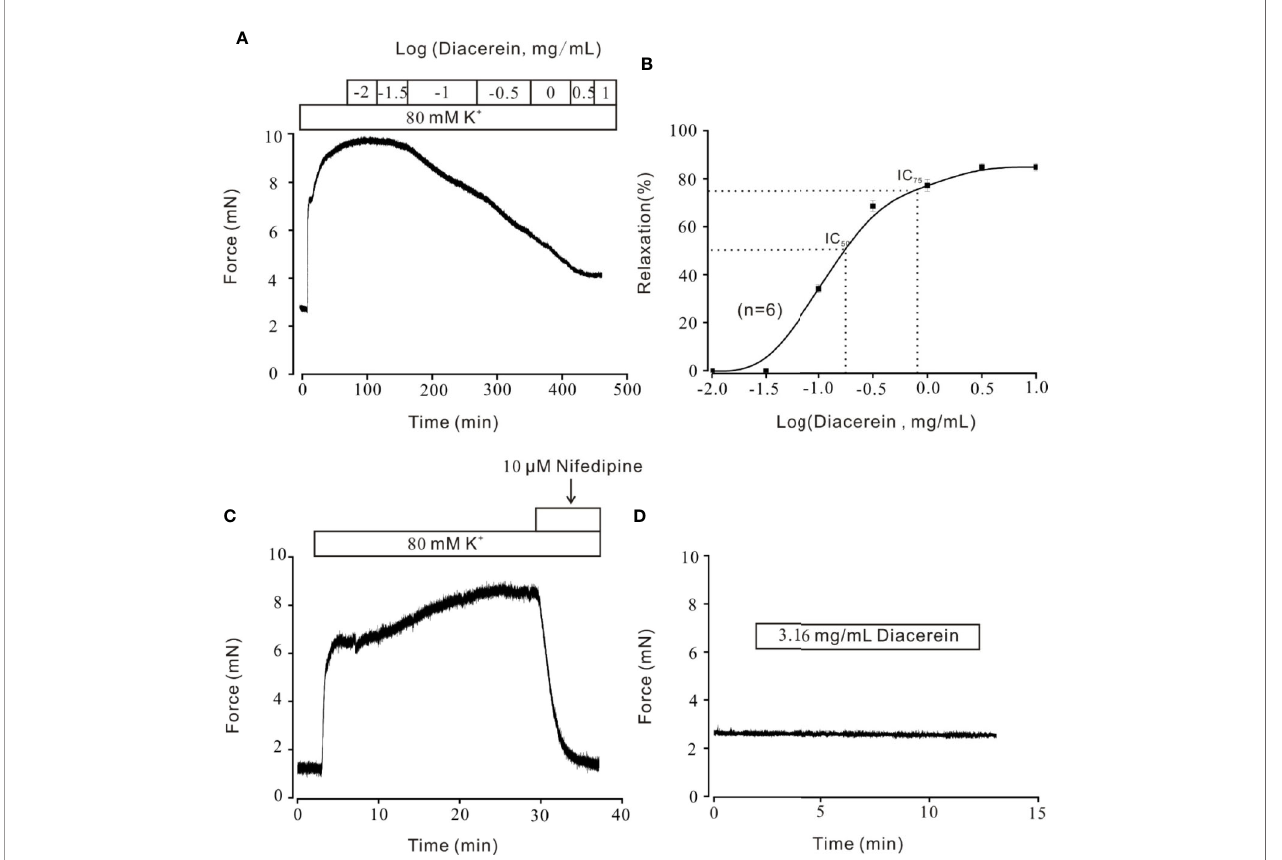
FIGURE 1 | Relaxant effects of diacerein on high K + -precontracted mouse tracheal rings (mTRs). (A) A representative tension record indicated that high K + induced a steady contraction which could be inhibited by 0.1~3.16 mg/ml diacerein in a dose-dependent manner. (B) Dose-relaxation curve of diacerein on high K + - precontracted mTRs (n = 6/6 mice). (C) High K + -induced precontraction was completely blocked by voltage-dependent L-type Ca 2+ channel (VDLCC) speci fi c blocker, 10 m M nifedipine (n = 6/6 mice). (D) 3.16 mg/ml diacerein had no effect on basal tone of mTRs (n = 6/6 mice).